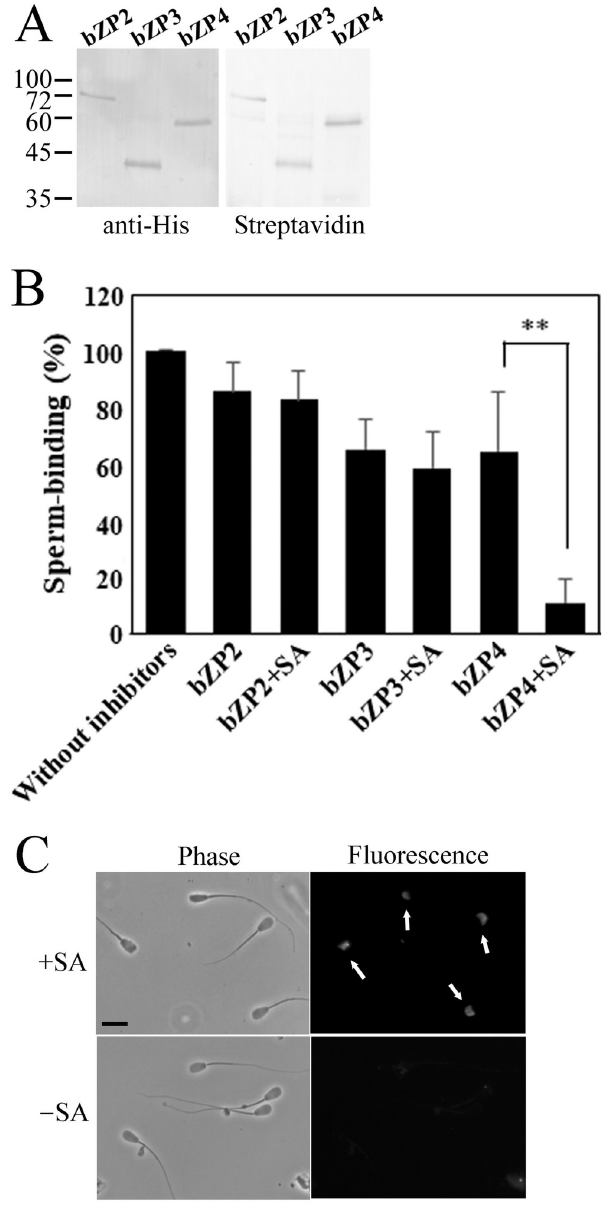
Fig 3. Sperm-binding activity of bovine ZP proteins multimerized in a solution using streptavidin-biotin binding. (A) Biotinylation of bovine ZP proteins. Bovine ZP2, ZP3, and ZP4 were biotinylated as described in Materials and methods section. These proteins were subjected to westernblot and detected with anti-His tag antibody (anti-His) used as a primary antibody (left panel). The same membrane was stripped and reprobed with horseradish peroxidase- conjugated streptavidin (Streptavidin, right panel). Molecular mass markers are indicated on the left of the membrane in kDa. (B) Effect of streptavidin on the competitive inhibition of biotinylated ZP proteins on sperm–ZP binding. Plastic wells were coated with recombinant bovine ZP2/ZP3/ZP4 mixture. Bovine sperm were preincubated with each inhibitor indicated below each bar and then added to the coated wells. bZP2, biotinylated ZP2; bZP3, biotinylated ZP3; bZP4, biotinylated ZP4; SA, streptavidin. The count of sperm bound to the bovine ZP2/ZP3/ZP4-coated wells in the absence of inhibitors (Without inhibitors) varied from 39 to 57 among experiments but was designated as 100% at each experiment. Assays were repeated four times. Data are presented as the mean ± SD. Neither bZP2 nor bZP3 showed significant increase in inhibitory activity by preincubation with SA, while bZP4 showed significant increase in inhibitory activity by preincubation with SA, as indicated by P < 0.01 ( �� ) above the line. (C) Indirect immunofluorescent detection of ZP4 bound to bovine sperm. Biotinylated bovine ZP4 was preincubated with streptavidin (+SA, upper panels) or without streptavidin (–SA, lower panels) and then mixed with bovine sperm. After